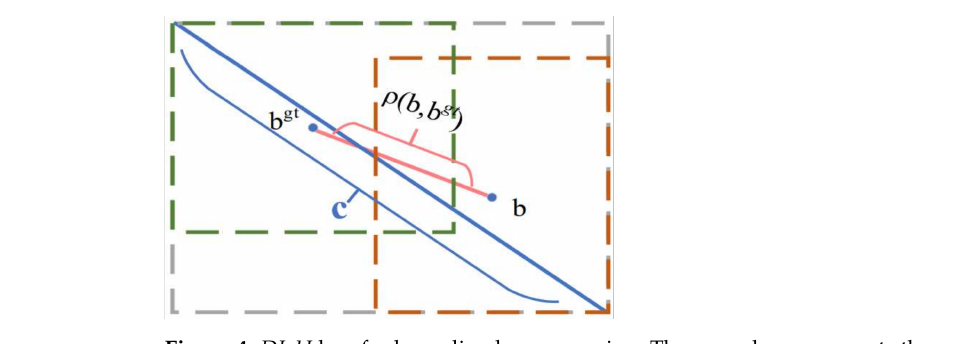
Figure 4. DIoU loss for bounding box regression. The green box represents the ground truth box; the orange box represents the prediction box; and the gray box is the minimum outer rectangle of